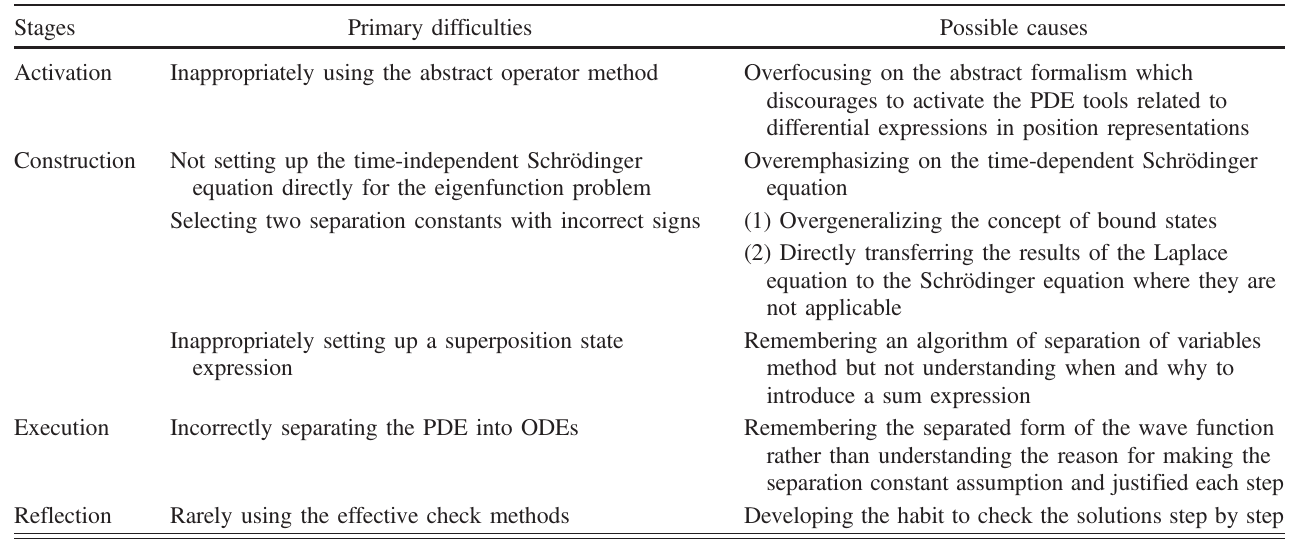
TABLE IX. Primary difficulties of students on solving eigenfunction problem, and the possible causes to which they relate. Stages